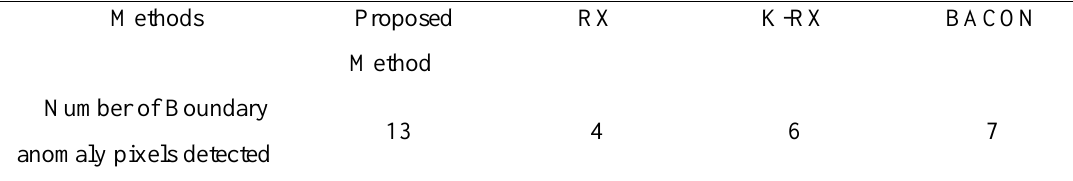
Table.1 Number of detected anomalies under minimized false